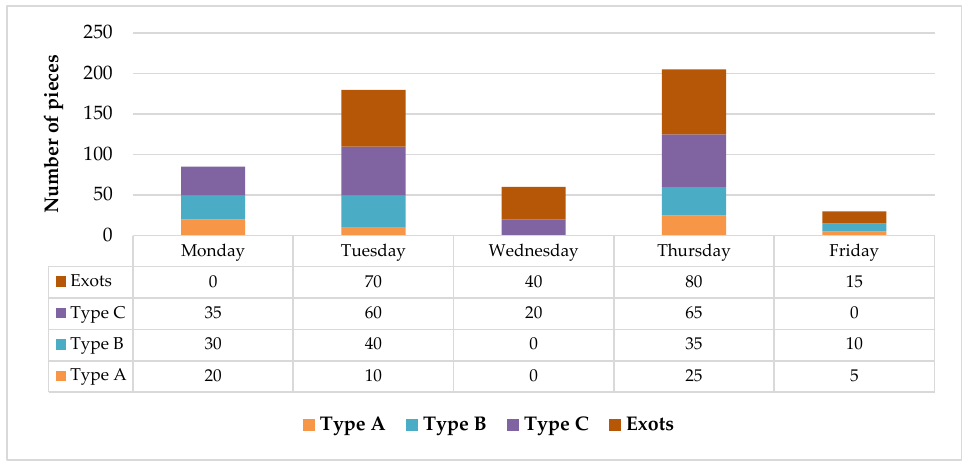
Figure 5. The stability of the manufacturing process is impacted by levelled production. Source: Authors’ compilation according to [70].